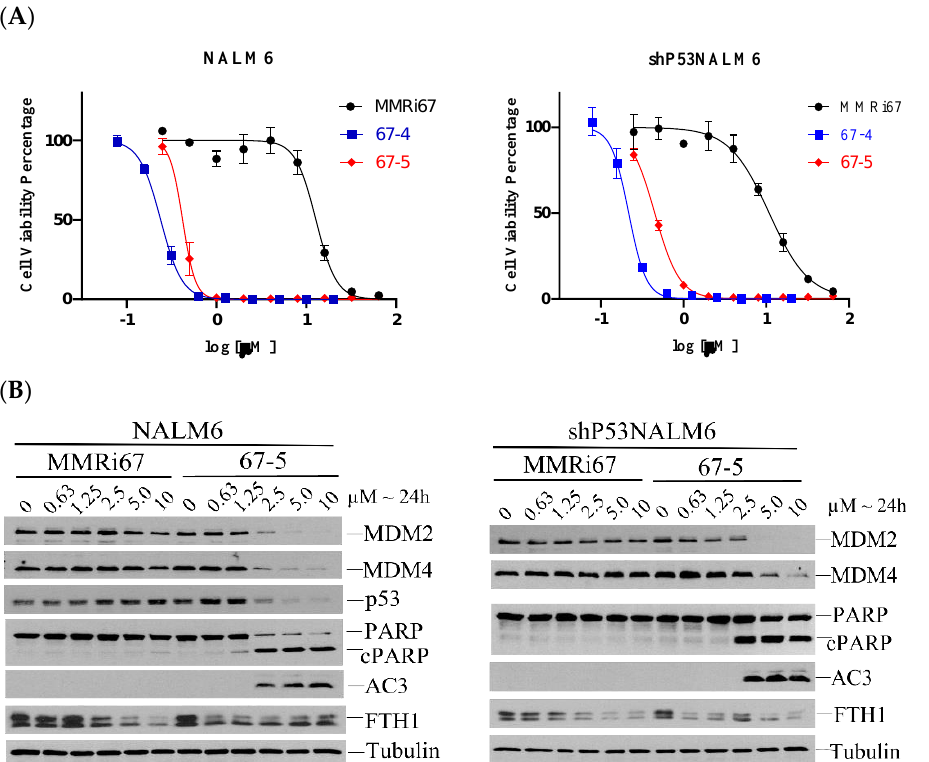
Figure 4. Anti-proliferation activity of 67-5 is associated with the downregulation of MDM2, MDM4, and FTH1 protein expression and caspase 3 activations. ( A ) Improved anti-proliferation activity of 67-4 and 67-5 compared with MMRi67 . Antiproliferation assays in NALM6 and shp53NALM6 cells. The IC 50 in NAML6 cells was 12.8 μ M for MMRi67 and 0.38 μ M for 67-5. The IC 50 in shP53NAML6 cells was 10.9 μ M for MMRi67 and 0.45 μ M for 67-5 . ( B ) Improved antiproliferation activity of 67-5 is associated with the downregulation of MDM2, MDM4, and FTH1, as well as caspase activation and PARP cleavage. WB analysis of indicated proteins and apoptotic effect induced by 67-5 compared to MMRi67 in both NALM6 and shP53NALM6